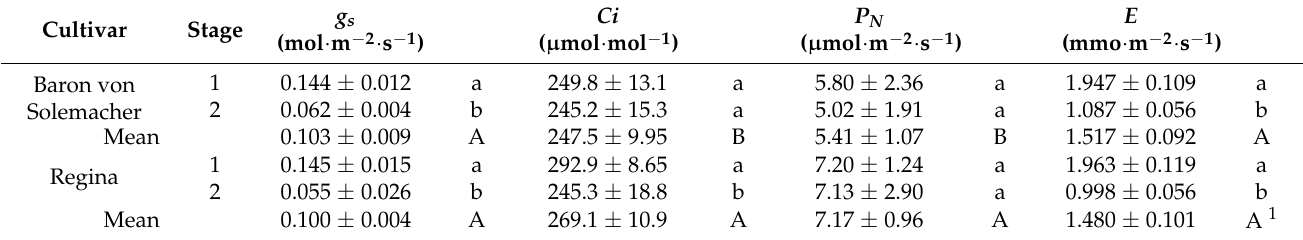
g s —stomatal conductance, Ci —intercellular carbon dioxide (CO 2 ) concentration, P N —net photosynthetic rate, E —transpi- Tukey’s test at p = ration rate; 1 various letters in rows indicate significant differences between growing stages (small letters)/cultivars (large letters) according to HSD Tukey’s test at p = 0.05.